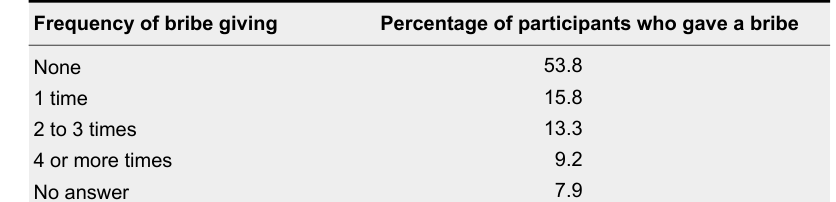
Frequency of Bribe